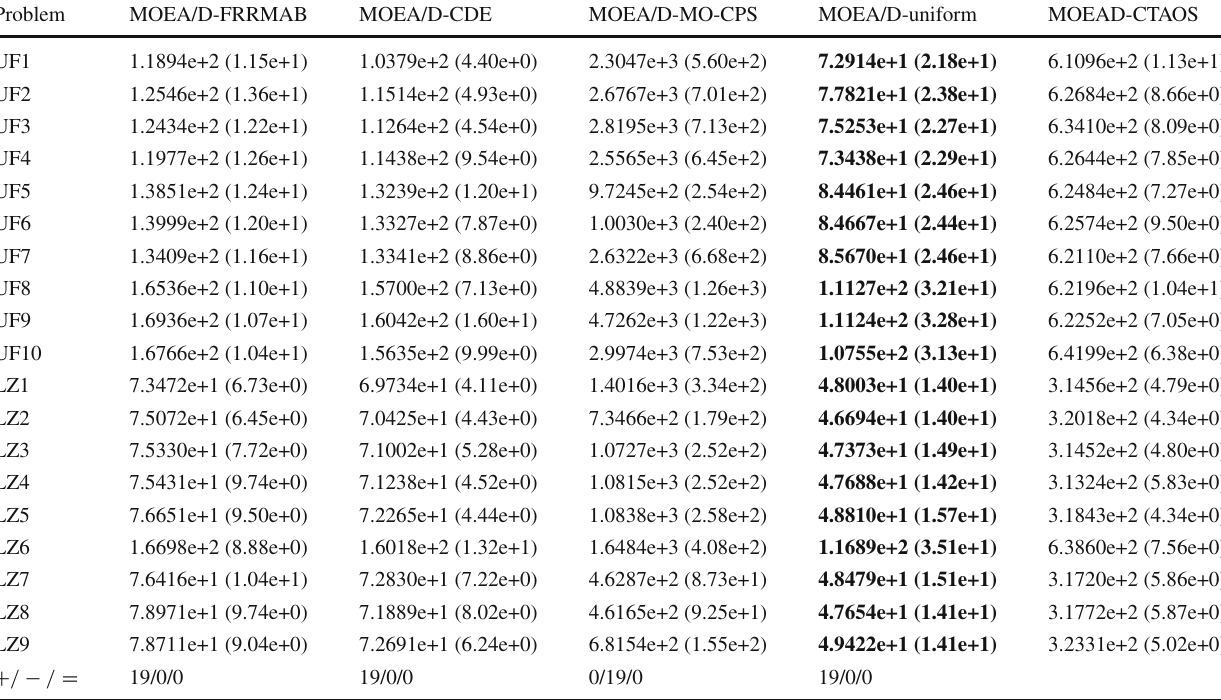
Table 5 Average and standard deviation runtime values obtained by MOEA/D variants with different AOS methods on each benchmark (30 runs) Problem